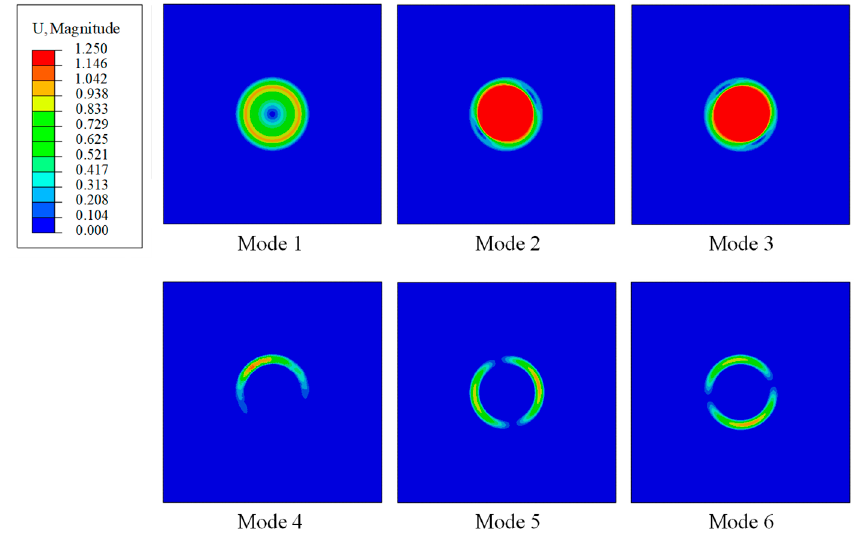
Figure 3. First six orders of natural modes of the coated vibrator model (mm).